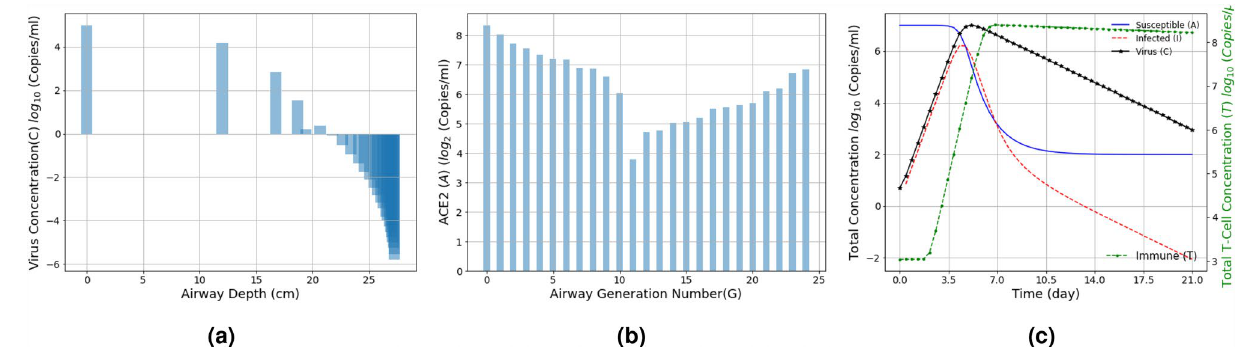
Figure 4. Virus deposition along the airway generation branches and infection ( a ) its changes with respect to the initial virus load and ( b ) distribution of ACE2 expressed cells over the respiratory airways, and ( c ) simulation of total viral particles ( C ), infected cells ( I ), ACE2 ( A ) and immune T-cell ( T ) concentrations over time as a result of the viral infection; T-cell count in the absence of virus T 0 T 0 range given in Table